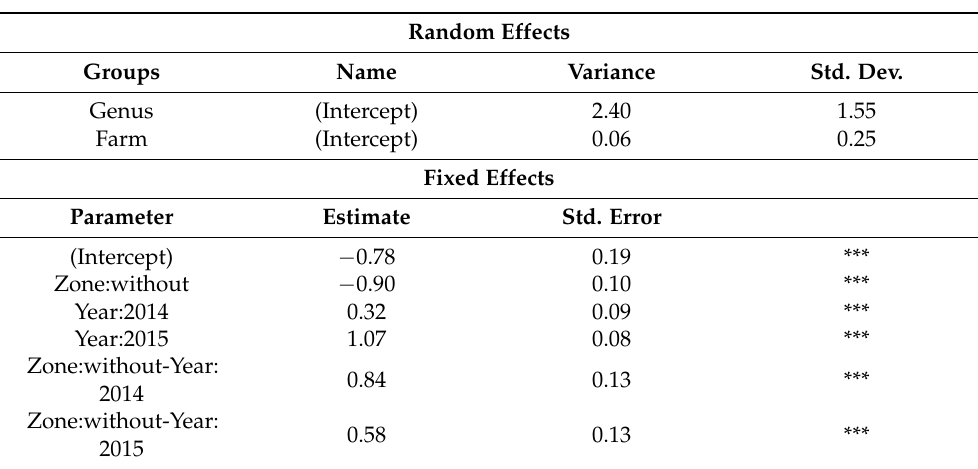
Table 6. The estimated regression coefficients in the fitted negative binomial regression model for the total number of